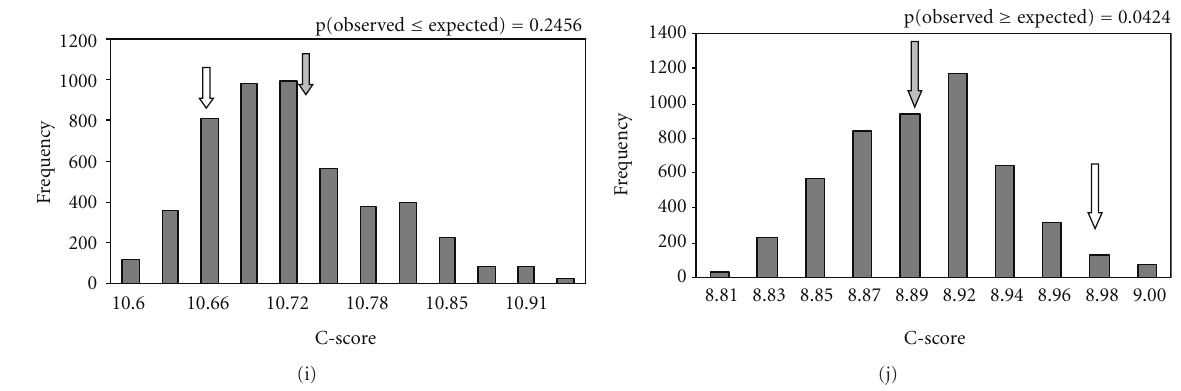
Figure 8: Co-occurrence analysis comparing 262 Winkler’s samples of leaf-litter ants in Serra da Bodoquena. (Full arrow represents the expected values, and empty arrow represents the observed values for C-score